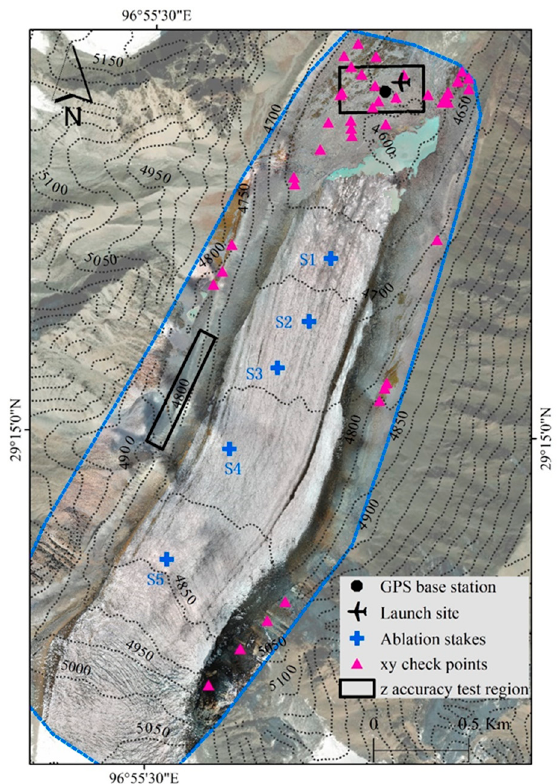
Figure 2. Orthomosaic of Parlung No. 4 Glacier from UAV imagery acquired in October 2019. Additionally shown are the locations of 43 off-glacier check points for validation of horizontal accuracy (pink triangles) and two off-glacier regions for the validation of vertical accuracy (black rectangles). Blue cross represents the locations of five ablation stakes. The contour lines were made by using the 12.5 m resolution Alos Palsar DEM from Alaska Satellite Facility. Blue line shows the boundary of the UAV mosaic. The background satellite image was taken from Esri DigitalGlobe (Redlands CA, USA).